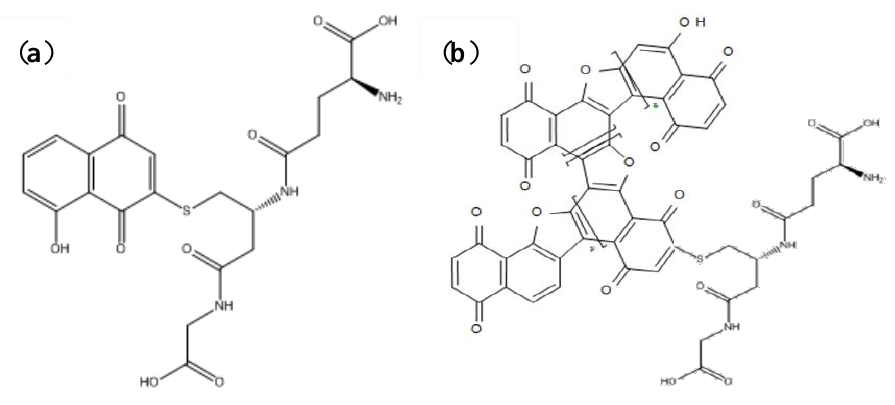
Figure 9. ( a ) Structure of the juglone-gluthathione conjugate (HNQ-Glu). ( b ) Structure of the corresponding conducting polymer